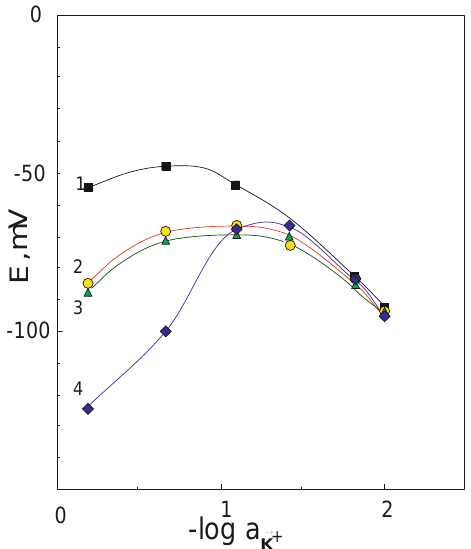
Figure 1. Calibration curves for polyurethane membranes containing K-TpClPB